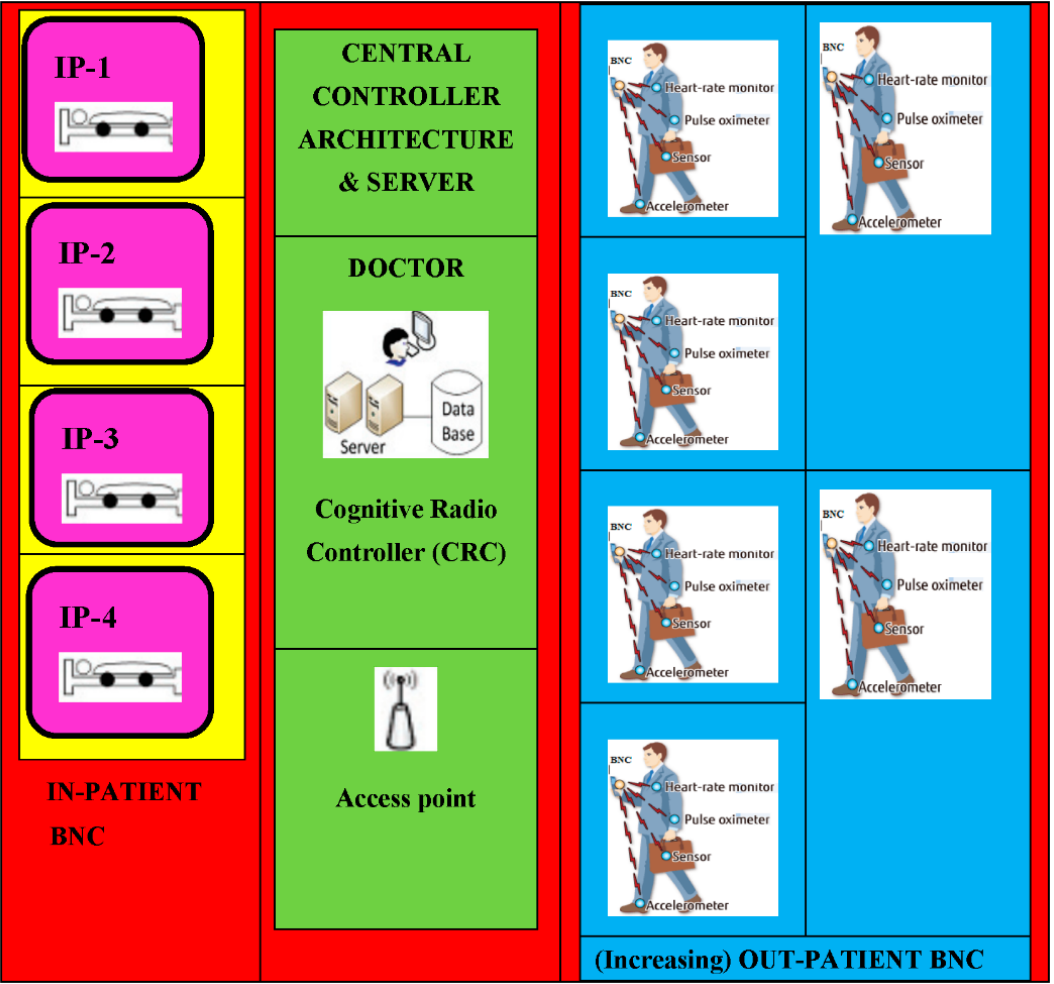
Figure 5. Central Cognitive Controller with an inpatient and out-patient based hospital scenario.